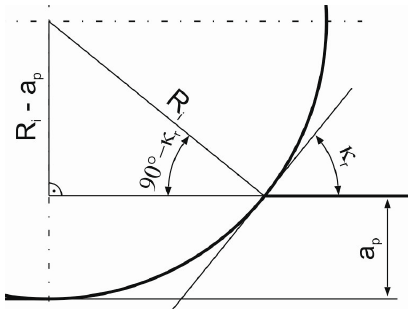
Figure 5. The method of determining the entering angle.